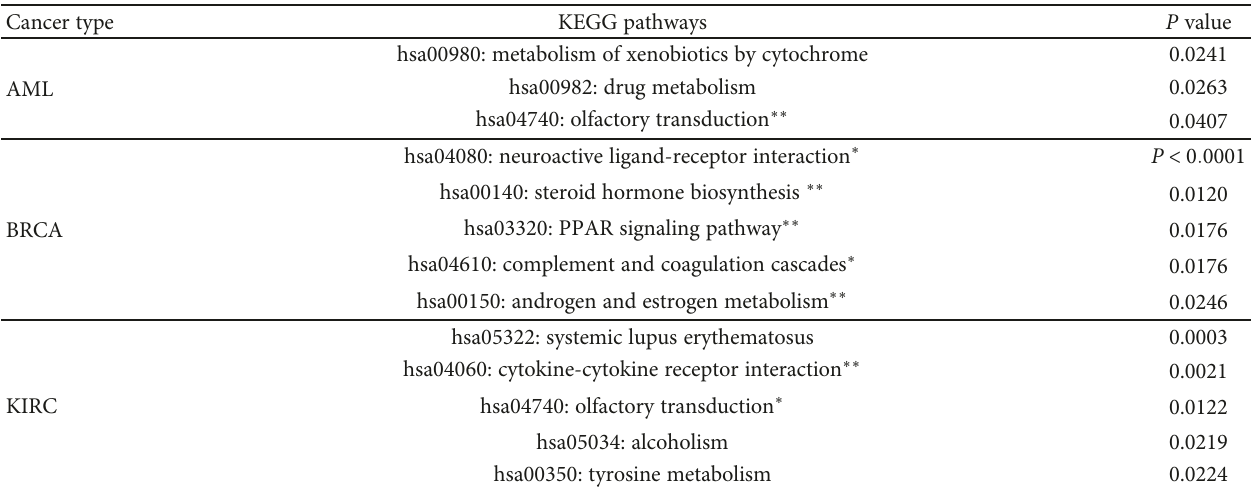
Table 4: The top 5 KEGG pathways enriched with the genes connected with the cancer-speci fi c miRNAs. Cancer